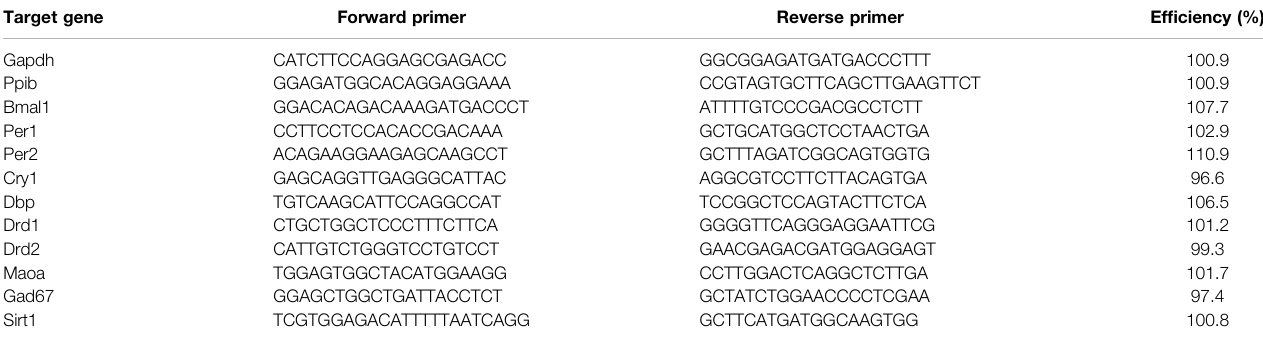
TABLE 1 | Primer list for quantitative real-time PCR. Target